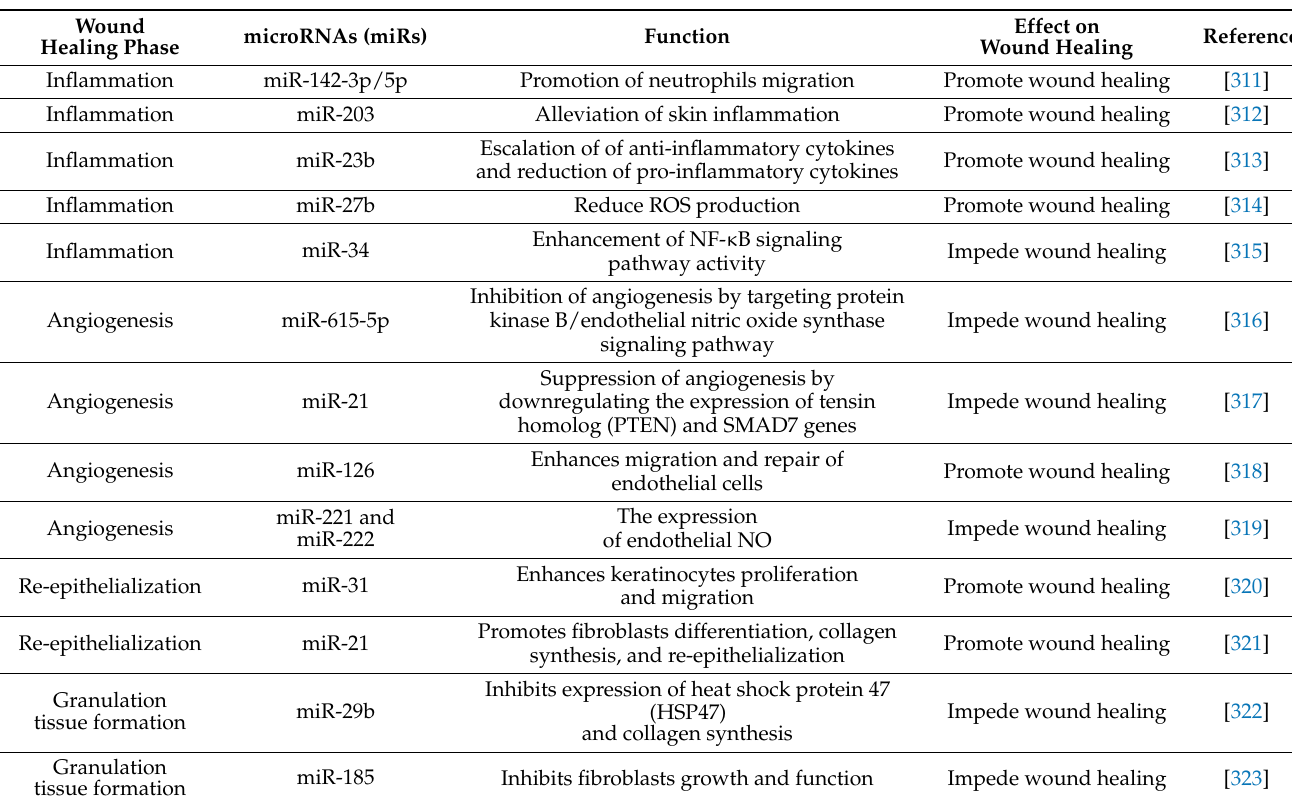
Table 5. A representative list of microRNAs (miRs) that are involved in different phases of wound